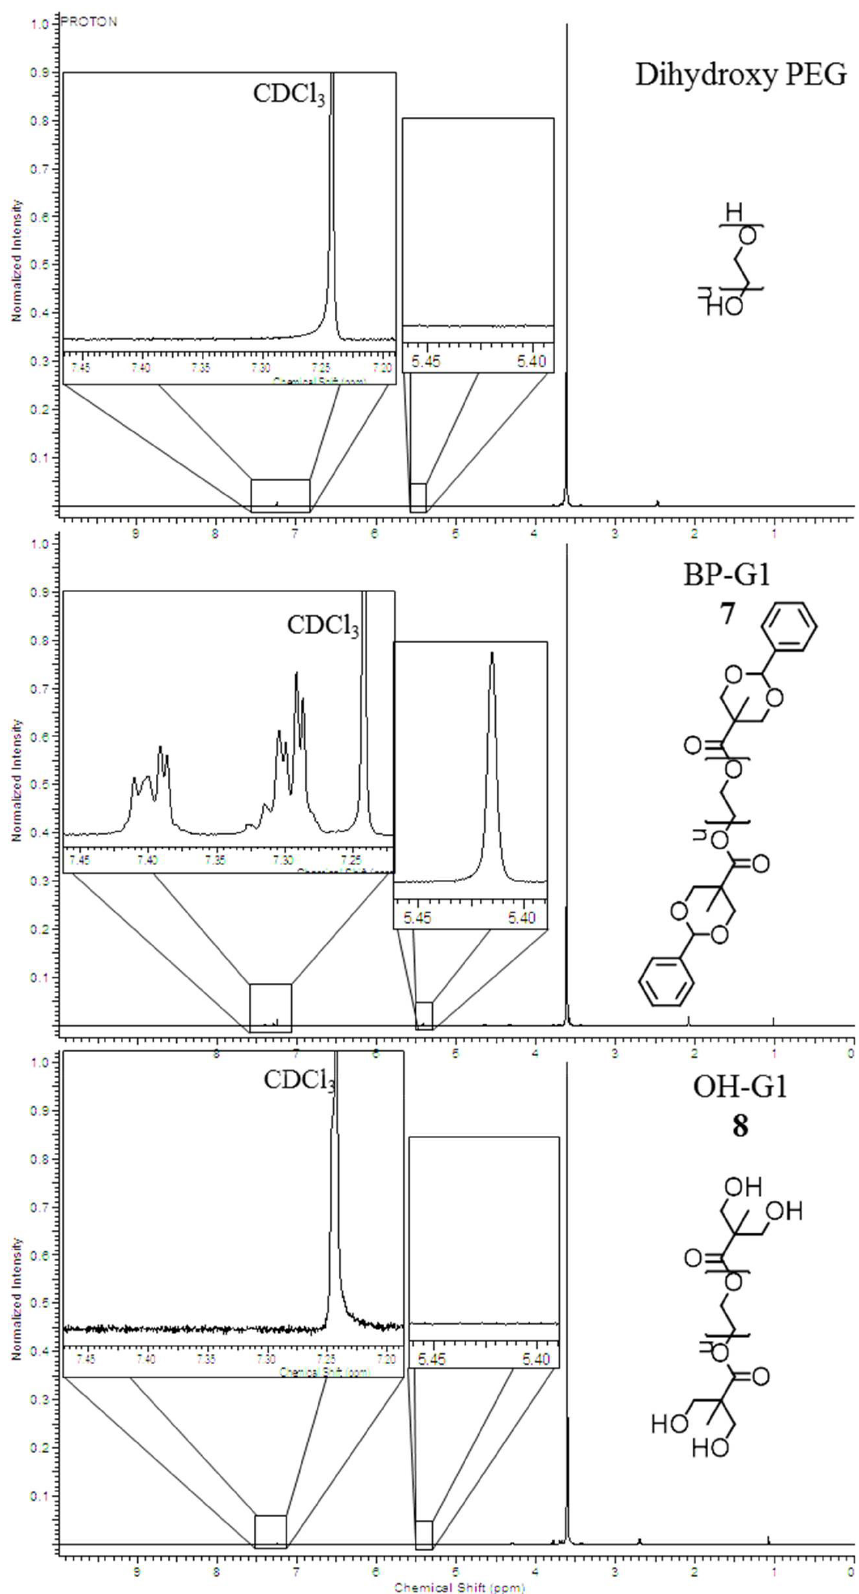
FIGURE 4 - 1 H NMR spectra of dihydroxy PEG starting material, BP-G1 (7), and OH-G1